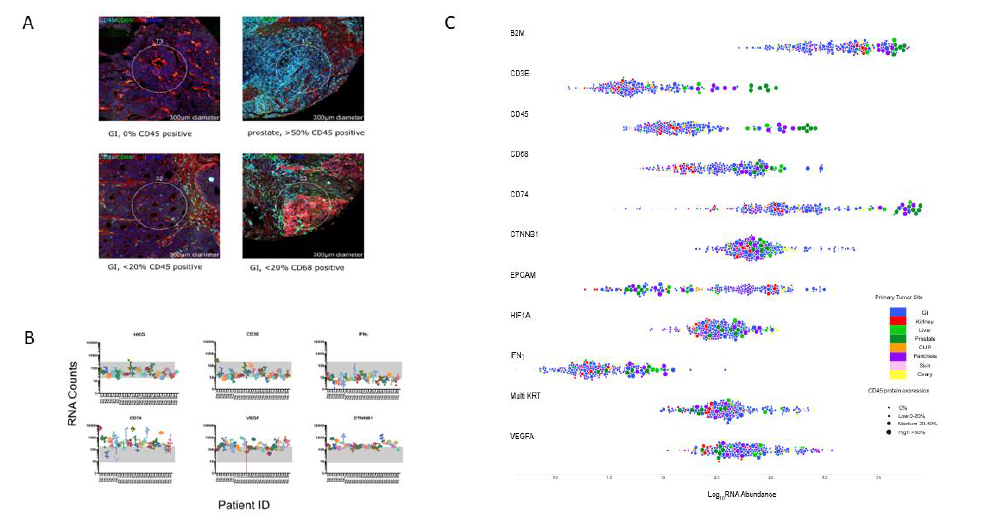
Figure 4. Digital spatial profiling (DSP) tumor regions were scanned for detection of immune cells in NET G3 / NEC tumors. ( A ) Fluorescent labeling aided in characterizing tumor versus immune cells that included hematopoietic marker CD45 (cyan) and monocyte / macrophage marker CD68 (green), NET / NEC tumor marker, synaptophysin (red), and DNA (blue). Representative images portray the varying levels of leukocytes (CD45 and CD68) within the tumors (gastrointestinal (GI) and prostate) and show staining for the immune cells within the regions of interest (ROIs) in a selected 300- µ m width (circled). ( B ) The distribution of RNA abundance in key genes for each patient surveyed in this study. Four to six ROI were selected for each patient. The geometric mean of 5 housekeeping proteins (HKG) was used as normalization and as a baseline reference for low and high RNA abundance. Highlighted are the low DSP RNA abundance for IFN γ and CD3E genes and high DSP RNA abundance for CD74, VEGFA, and CTNNB1. ( C ) Swarm blot to stratify the RNA abundance of high and low expressed genes relative to the scoring of ROIs with high CD45 positive cells (indicated by circle size). To determine the relative amount of CD45 positive cells within an ROI, the immunofluorescent 300- µ m scanned regions were qualitatively scored. In the legend, the colors represent the tumor